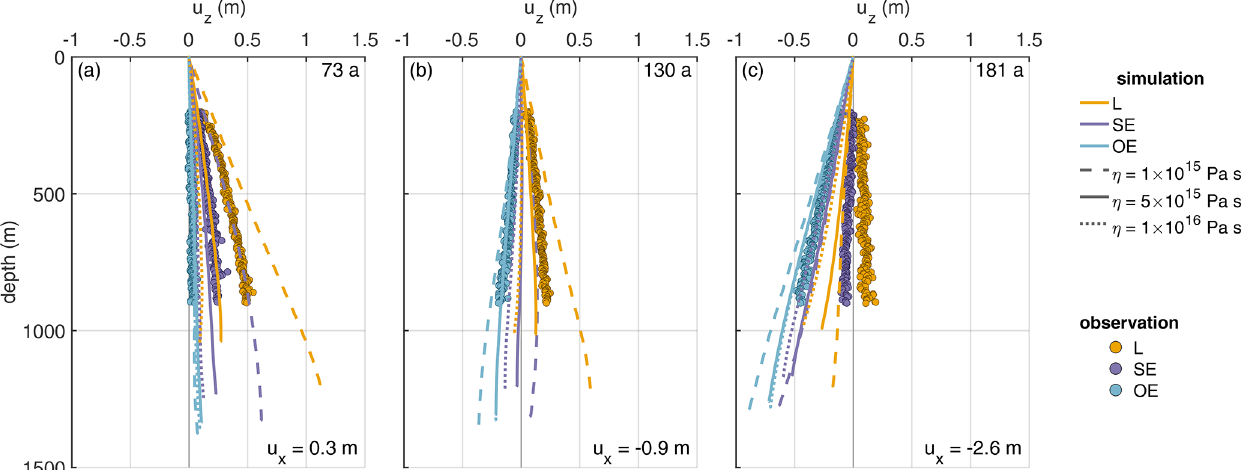
Figure B9. Second experiment: comparison of displacements ( u z ) derived from observations (dots) and the simulations for different viscosi- ties displayed by different line styles (lines). The different panels show the displacement for (cid:49)t = 1 year allocated to the simulation time (upper right corner). The numbers in the lower right corners give horizontal displacement u x derived from ε zz of the pRES measurements outside the channel (OE), with positive values representing compression and negative values